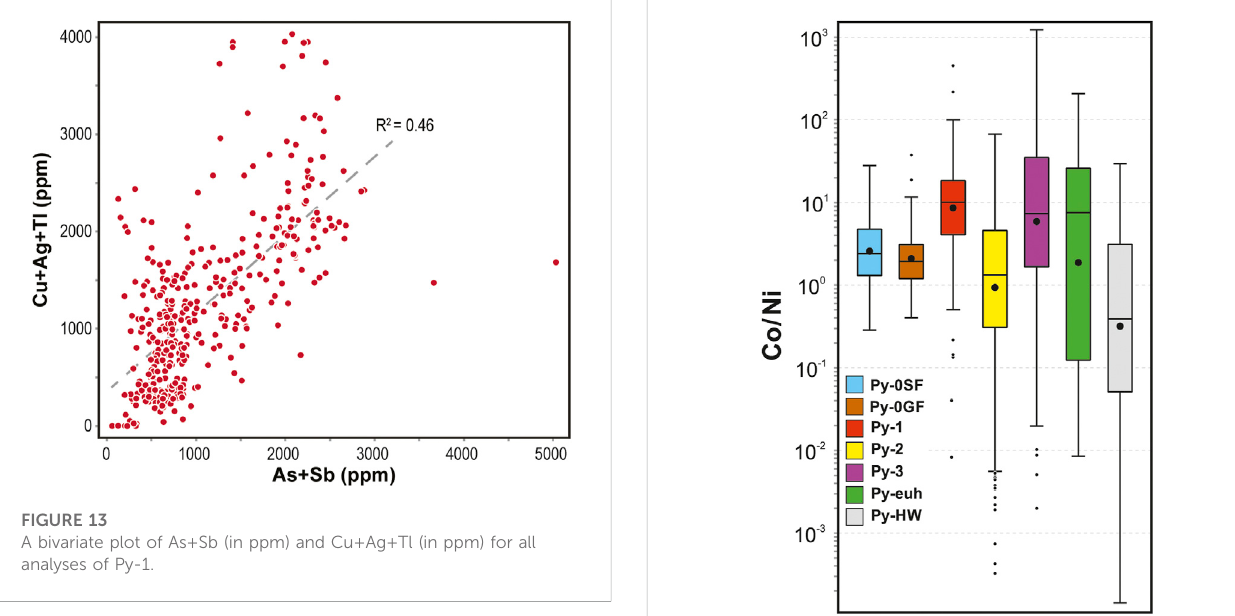
Figure 14). For diagenetic Py-0 this hydrothermal Co/Ni signature could